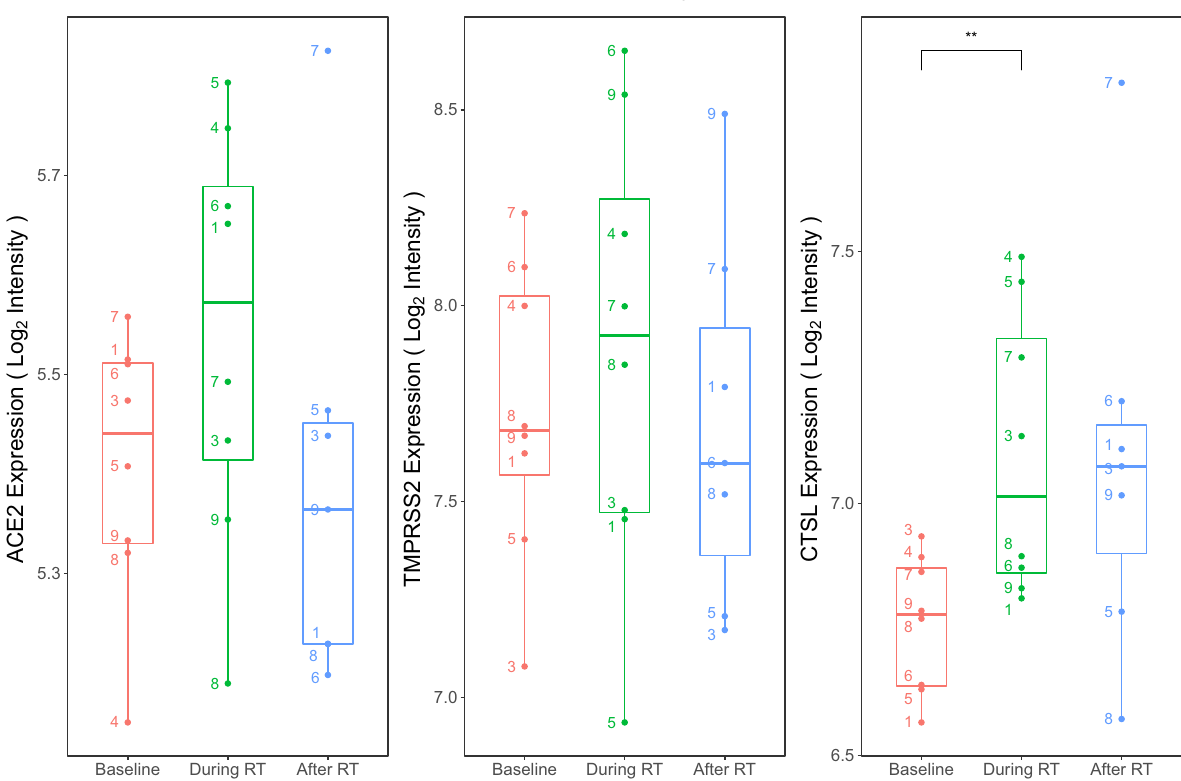
Figure 5. Effects of radiotherapy on ACE2, TMPRSS2, and CTSL expression. Expression of ACE2 (left) , TMPRSS2 (middle) , and CTSL (right) in buccal mucosa before, during, and after radiotherapy (RT) among 8 tonsillar squamous cell carcinoma patients from the GSE103412 data set. The probe intensity for each gene was log 2 transformed and visualised for each treatment group to present normalized gene expression values. Paired t-tests were performed between adjacent time points and significant differential expression between groups was labelled. The numbers denote each of the 8 individual patient’s data points. Of note, patient #2 ′ s data was not available for download from the Gene Expression Omnibus (GEO) database. ** p < 0.01 between baseline and during